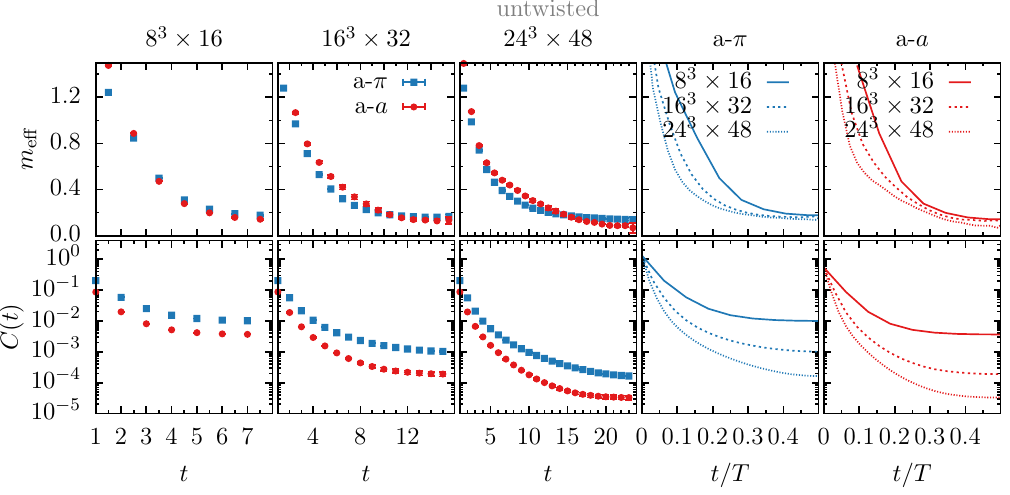
Figure 5 . Top/Bottom: effective masses/correlators of the adjoint pion and the adjoint a at fixed bare gluino mass m = -1.0506 and lattice coupling β = 5.0, without mass twist. From left to right the first three columns show results for a- π and a- a from a 8 3 × 16 , 16 3 × 32 and 24 3 × 48 lattice. The last two compare a- π and a- a for different lattice sizes. Most error bars are smaller than the symbol size. In the last two columns, data points are connected by lines and symbols and error bars are omitted for better